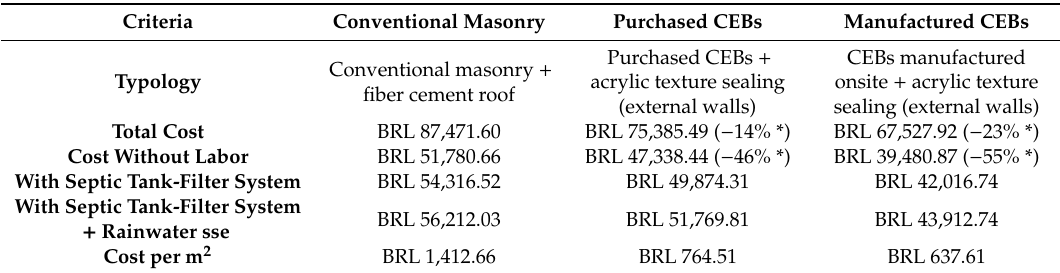
Table 15. Comparison of costs between conventional system and CEB reinforced masonry, having as reference the residential model Embryo 2 with 61.92 m 2